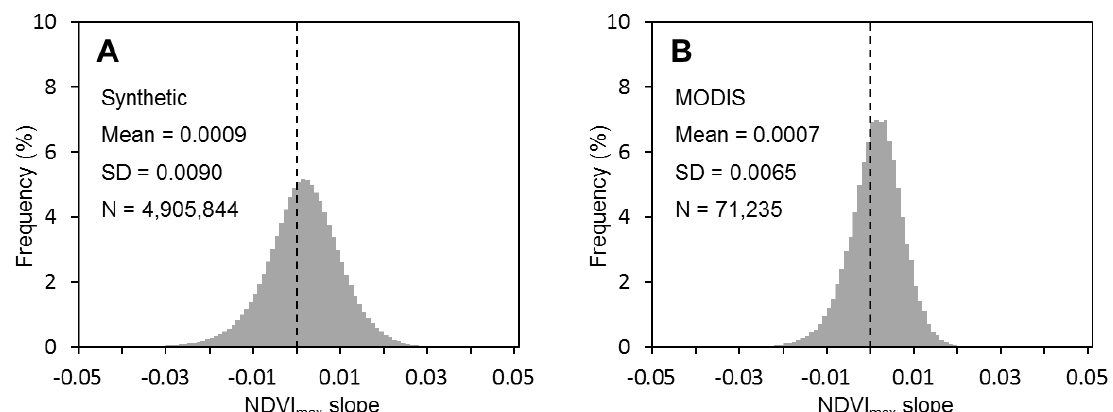
Figure 11. Histograms of the frequency of the NDVI and ( B ) MODIS NDVI time series max